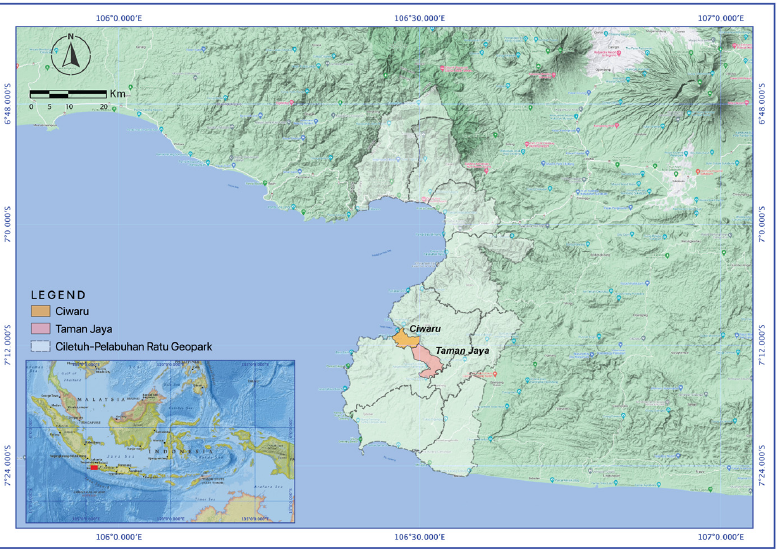
Figure 1. Orientation Map of Ciwaru and Tamanjaya Village in Ciletuh-Palabuhanratu Geopark. Source: Researchers’ analysis created using QGIS 3.4.